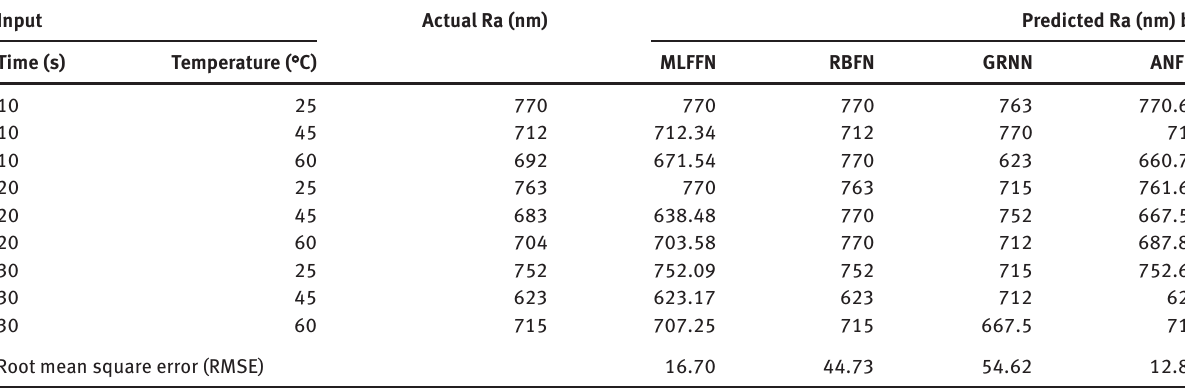
Table 5 Comparison of estimated outputs and RMSE.